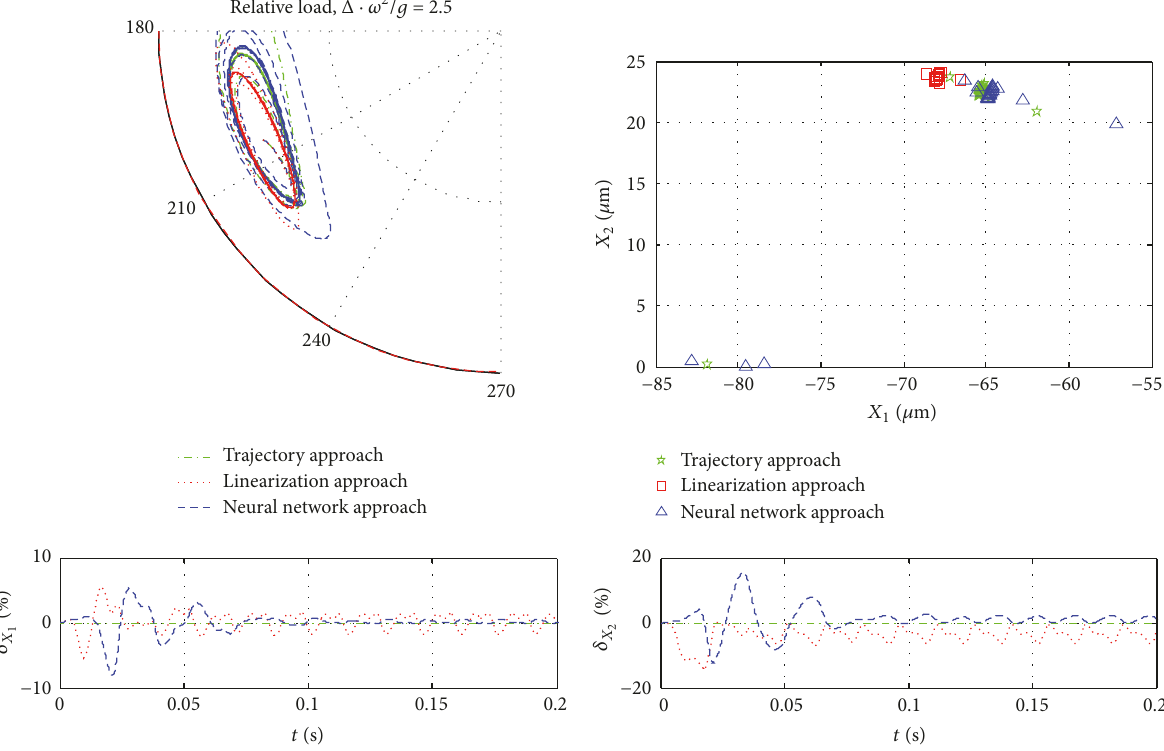
Figure 5: Comparative calculation results in the form of trajectories, Poincare maps, and error plots with different values of dimensionless load.